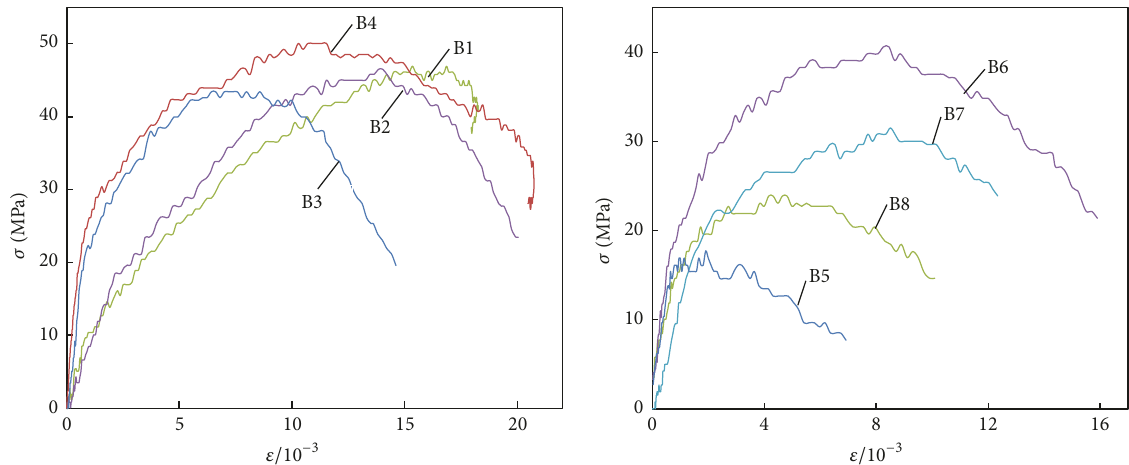
Figure 9: Stress-strain curves of natural and 7D saturated specimens in uniaxial static-dynamic loads.